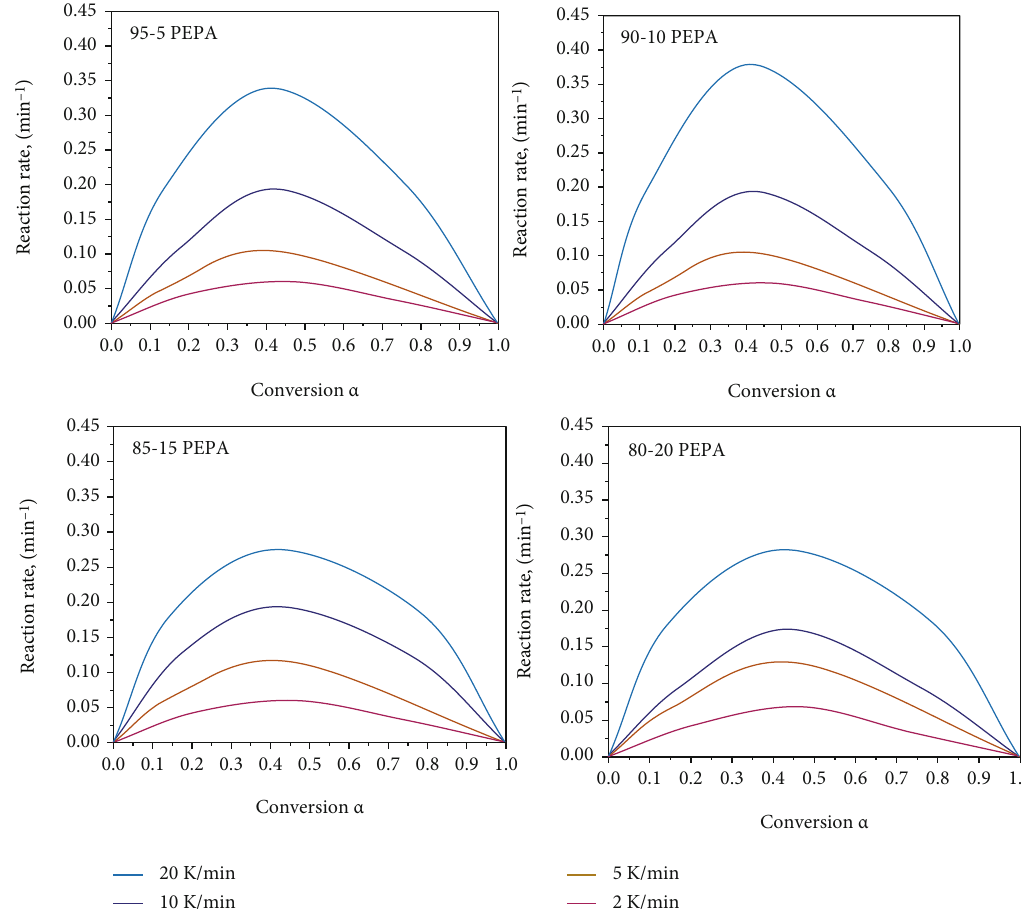
Figure 5: Nonisothermal reaction rate d α / dt as a function of cure degree α for the curing reaction at the indicated heating rates.